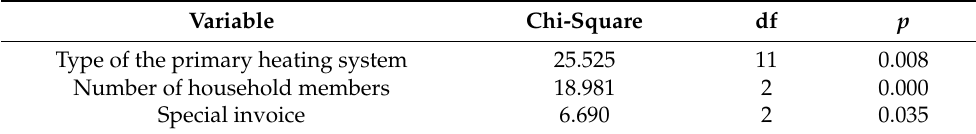
Table 2. Results of the Kruskal–Wallis test between “Electricity Cost” and individual variables. Variable